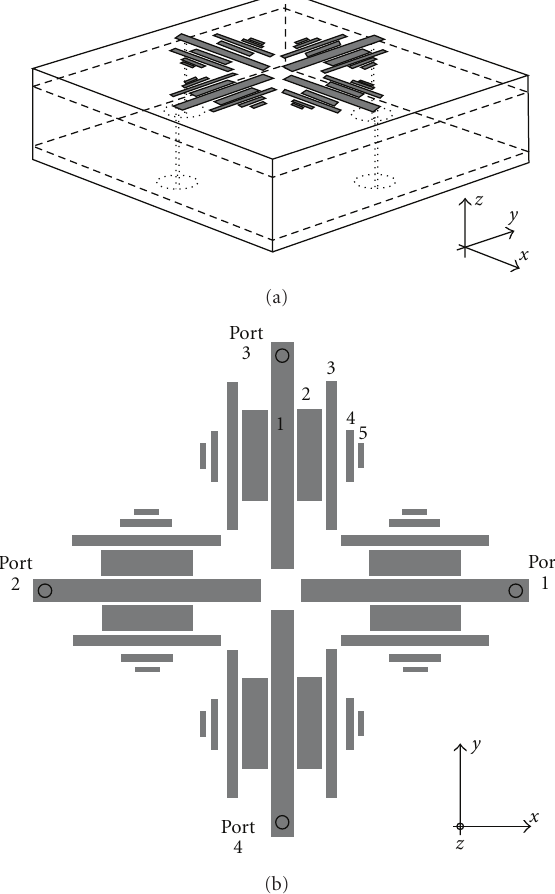
Figure 1: Geometry of the radiating element under analysis in Section 3, based on four rhombic coplanar elements printed on the top of a three-layer configuration. (a) 3D view of the antenna. (b) Upper view of the structure. Lowest substrate: thickness h = 1 . 5mm, relative dielectric constant ε r = 2 . 2, loss tangent tan δ = 9 · 10 − 4 (duroid RT 5880 Rogers). Middle substrate thickness h = 7 . 5mm, relative dielectric constant ε r = 4 . 4, loss tangent tan δ = 200 × 10 − 4 (FR4 epoxy). Uppermost substrate thickness h = 2mm, relative dielectric constant ε r = 2 . 2, loss tangent tan δ = 9 · 10 − 4 (RT 5880 Roger). Overall unit-cell dimension 43 × 43mm. Geometrical parameters of the patches: w 1 = 1 . 9mm, l 1 = 17 . 3mm, w 2 = 2mm, l = 7mm, w = 1mm, l = 11 . 3mm, w = 0 . 6mm, l = 4mm, 2 3 3 4 4 w = 0 . 4mm, and l = 2mm ( w i and l i are the width and the length 5 5 of the i th patch, resp.). Diameter of the probe d = 0 .